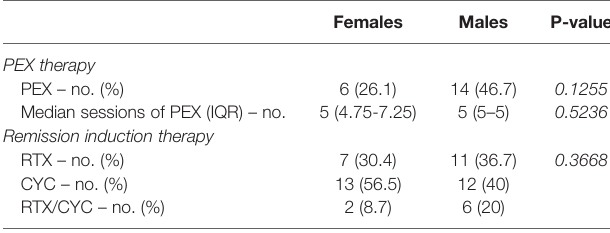
TABLE 5 | Sex differences in choice of PEX and remission induction therapy in ANCA GN.